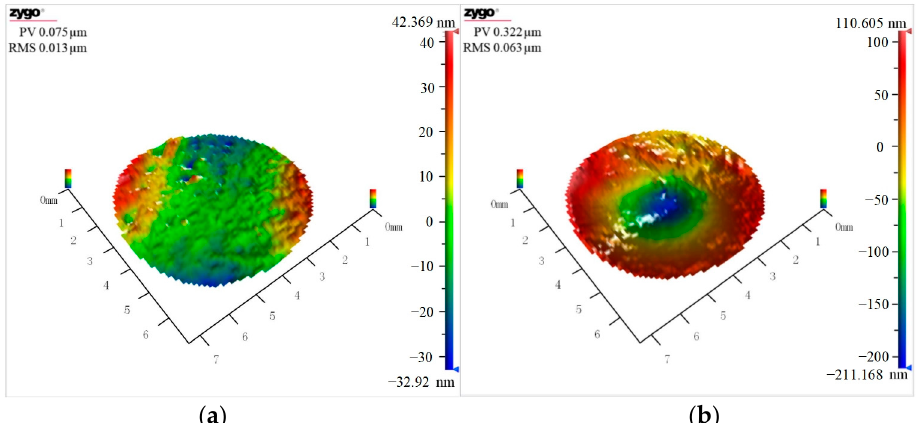
Figure 6. Topography contrast diagram. ( a ) Original morphology of workpiece. ( b ) Workpiece morphology after 0.5A current processing.